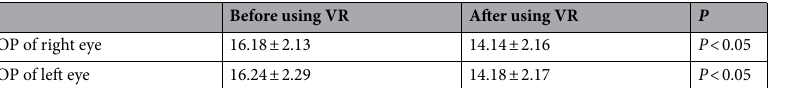
Before using VR